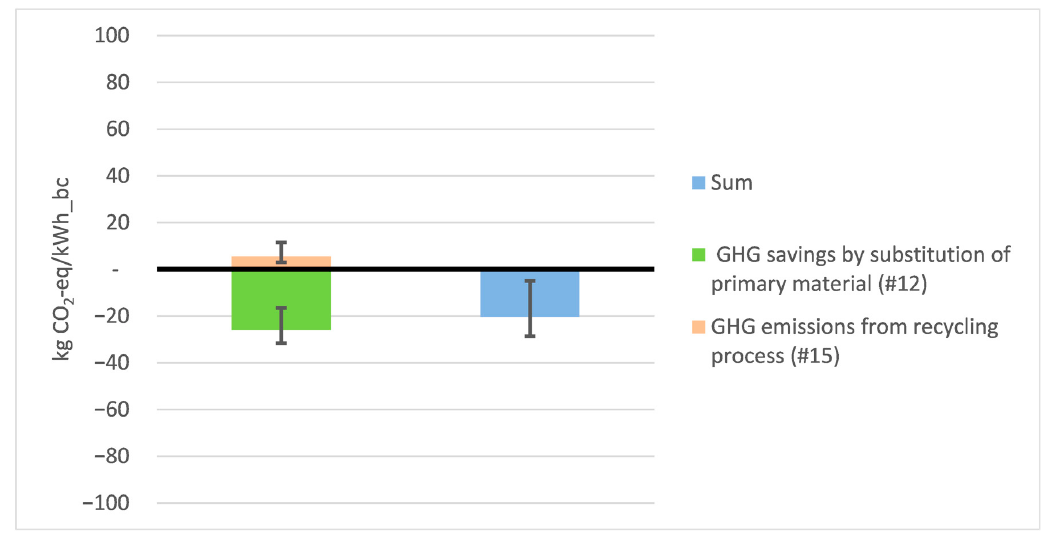
Figure 8. GHG emissions and savings of recycling (results based on median, 25%-quantile, and